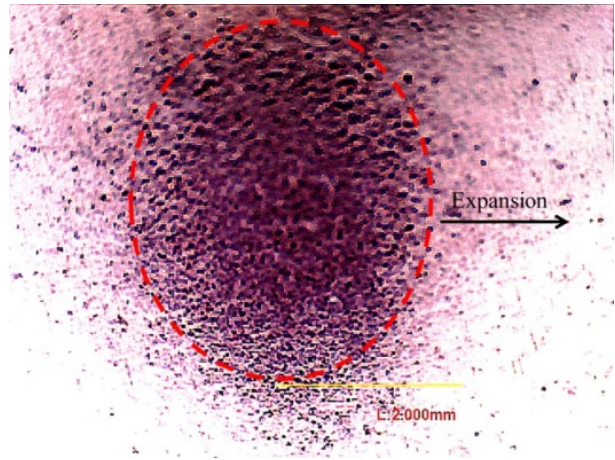
/ d = 3, D / d = 10, α = 120 ◦ , P c c 1 1